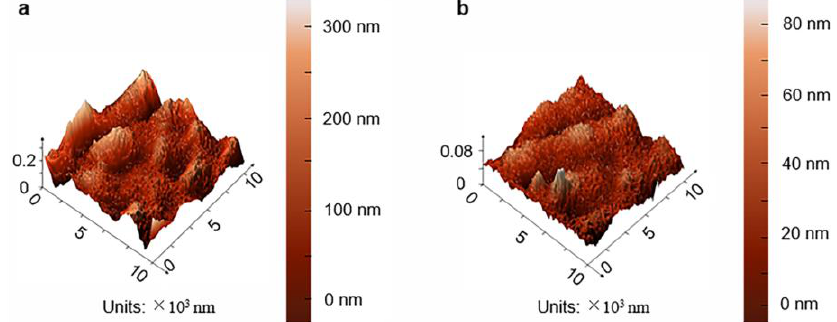
Figure 4. Surface roughness of ( a ) HfC coatings and ( b ) HfTaC 2 coatings.